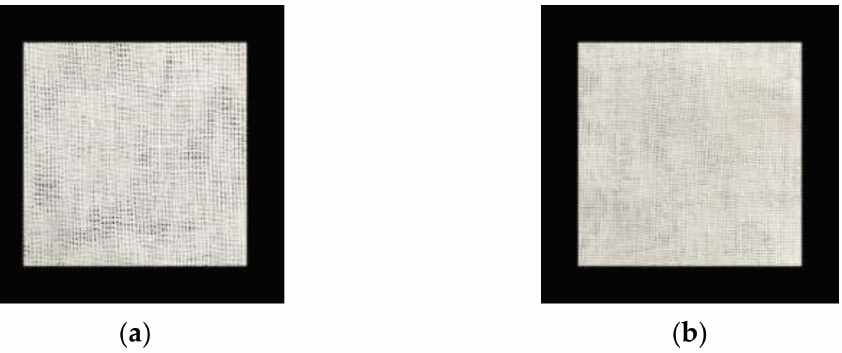
Figure 1. Two dressings. ( a ) Conventional cotton gauze used for control group; ( b ) brown cotton bleached gauze used for the experimental